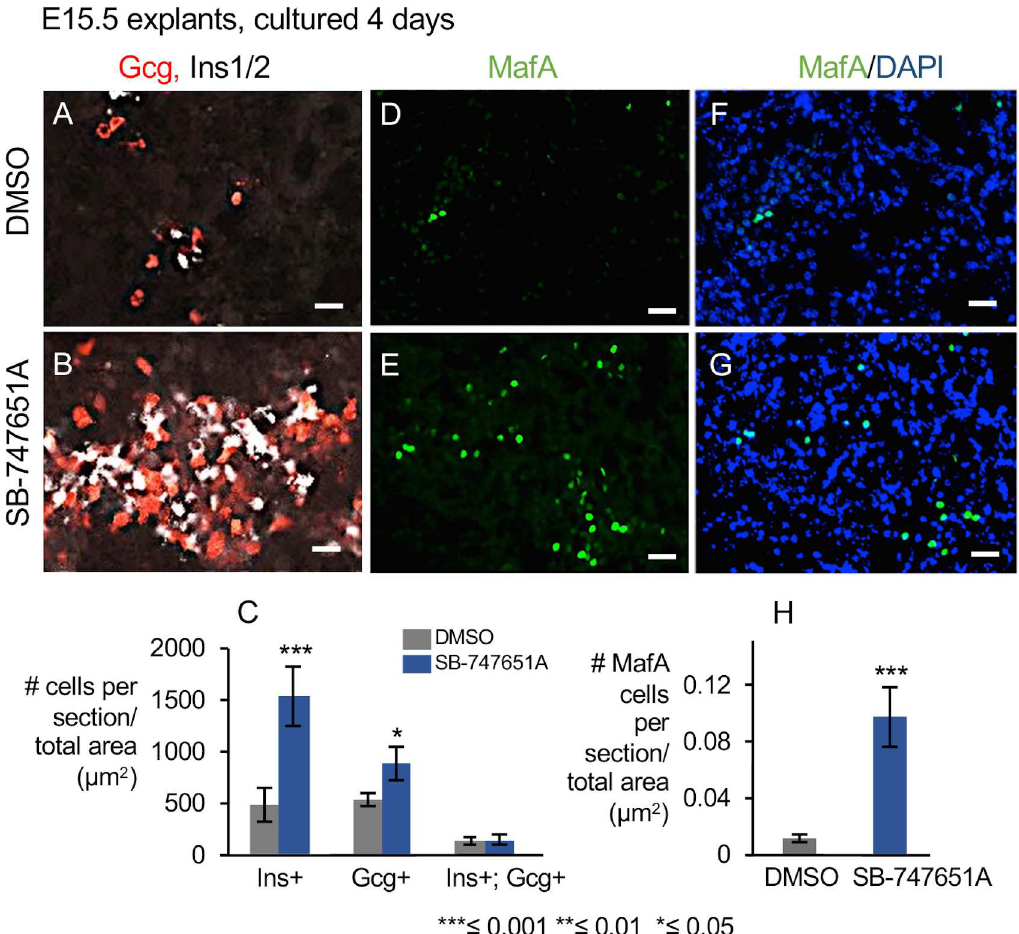
Fig 6. Expression analysis of Ins1/2; Gcg and MafA upon SB-747541Atreatment. (A-C) Co-expression and quantification of Ins1/2 and Gcg expressiondomainsby immunohistochemistry on pancreatic sections from E15.5 stage explantsculturedfor 4 days in DMSO or SB747541A. P-values= 4 × 10 − 4 for Ins1/2+;Gcg- and 0.02 for Gcg+; Ins1/2-, n (cid:21) 5 pancreata each for DMSO and SB-747651A treatment and for each biologicalreplicate, n = 3 biological replicates. (D-H) Expression and quantification of MafA positive cells in pancreatic explantstreated with DMSO (D, F) and SB-747541A (E, G) for 4 days. Scale bar on all panels = 25 μ m. Valuesare averages of 2 independent experiments ± standarderror unless otherwisestated. All P-values were calculatedby Student’s t test, comparing DMSO and SB-747651Atreated samples in 2 independentexperiments, * (cid:20) 0.05, ** (cid:20) 0.01, *** (cid:20) 0.001,